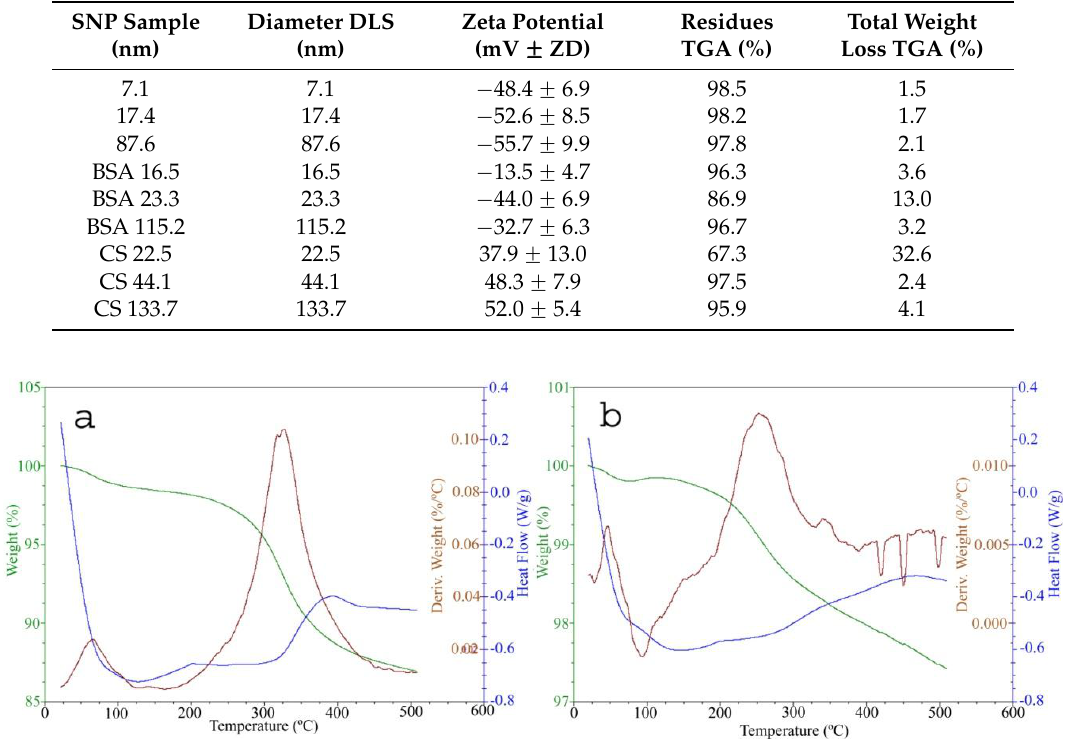
Figure 2. DSC-TGA analysis. ( a ) BSA 23.3 nm and; ( b ) CS 44.1 nm. Green, brown and blue lines represent TGA, DSC, and DTG values, respectively.